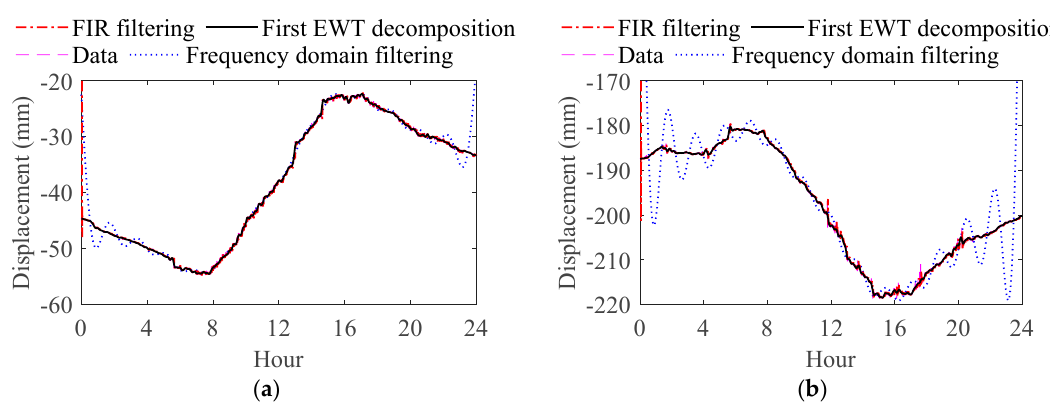
Figure 5. Longitudinal displacements and the associated low-frequency portion at the south girder end over the course of one day: ( a ) bearing (B-7-11); ( b ) expansion joint (EJ-7-1).